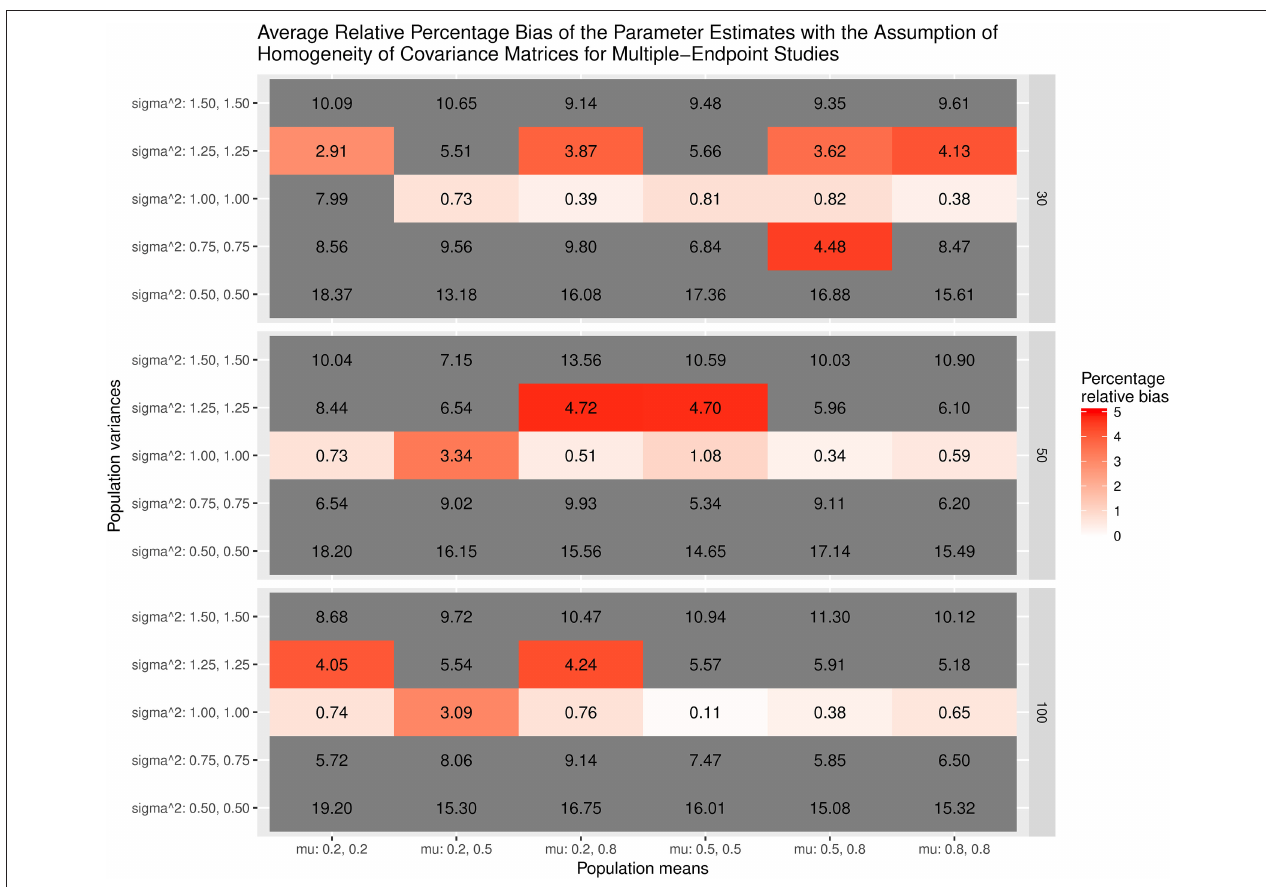
FIGURE 7 | Relative bias of the average of the parameter estimates for the multiple-endpoint studies with the assumption of homogeneity of covariance matrices.